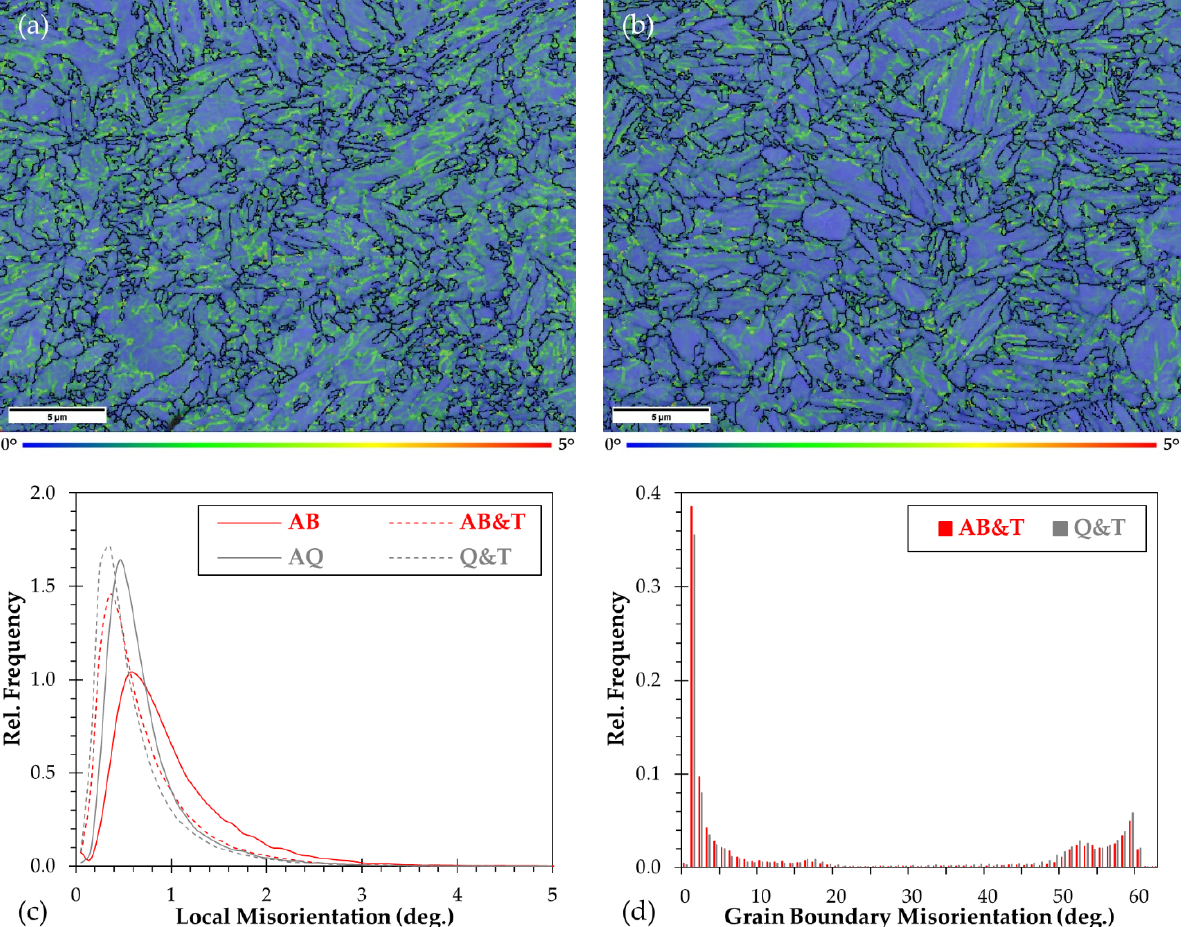
Figure 4. KAM maps of W-4130 steel in ( a ) AB & T and ( b ) Q & T states. Relative frequency of ( c ) local misorientation and ( d ) grain boundary misorientation of the steel in different thermal treatment conditions.